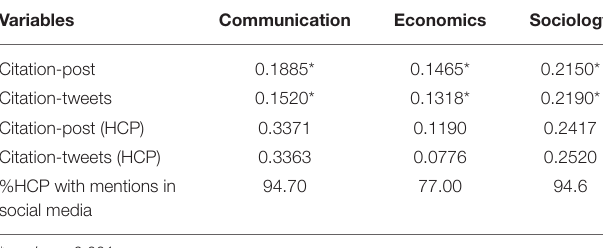
TABLE 5 | Bibliometric and altmetric correlation.